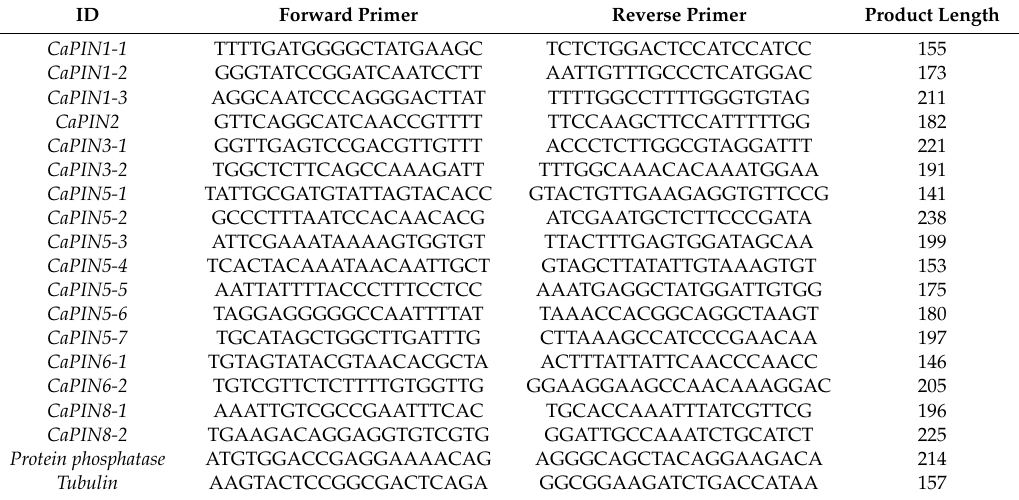
Table 2. Primers used for qRT-PCR